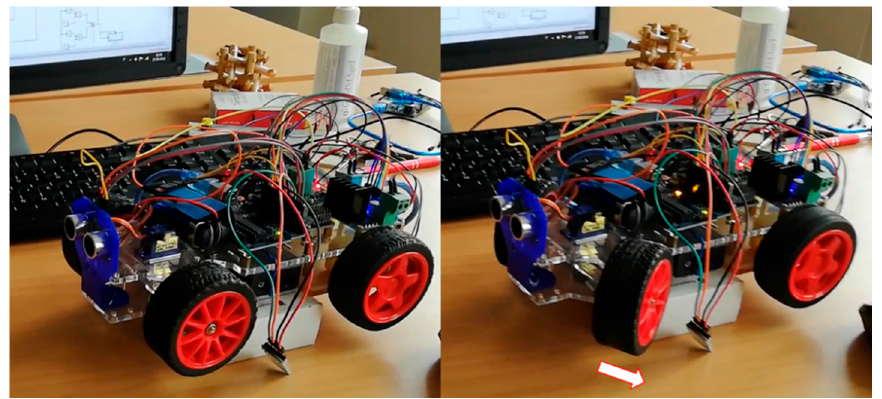
Figure 6. Snapshot of an in vivo proof of concept validation on the acrylic prototype car system designed in [3].